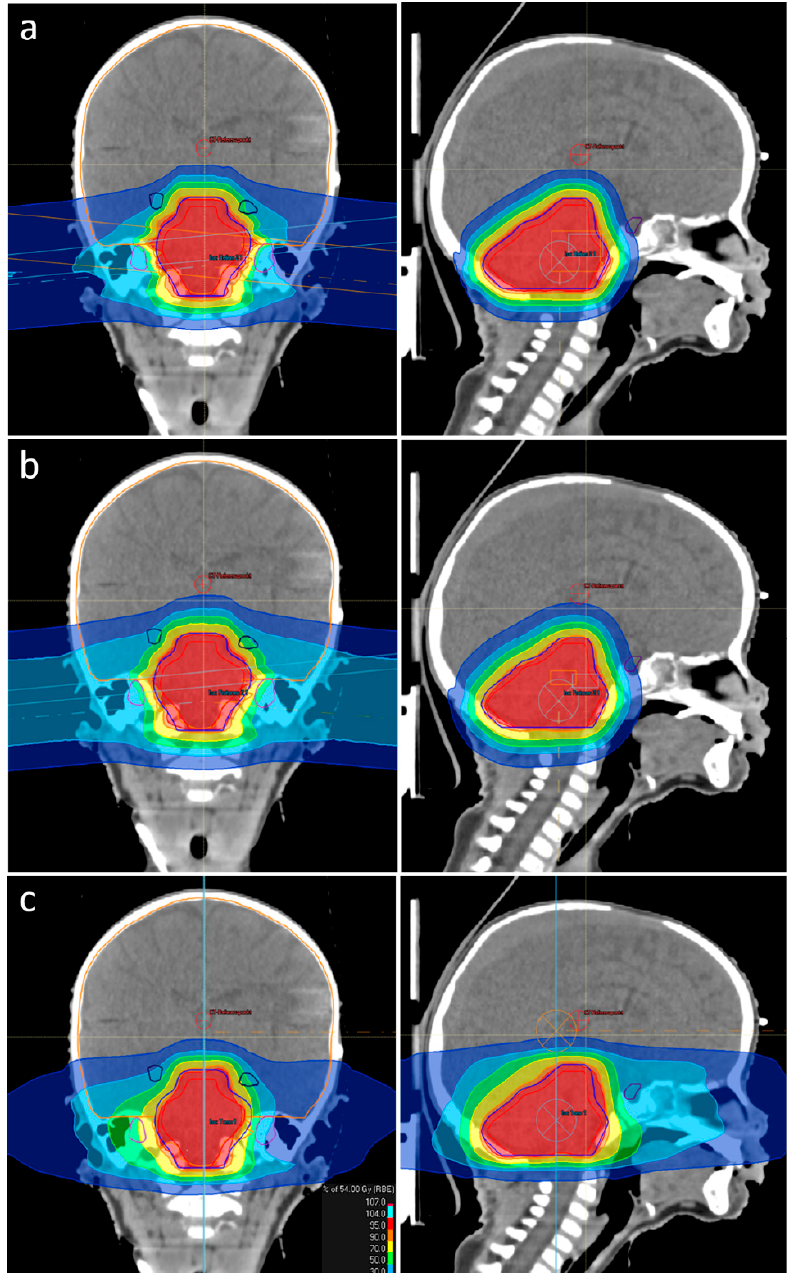
Figure 3. Comparison of dose distribution for a patient with ependymoma. ( a ) Helium ion beam therapy plan; ( b ) Proton beam therapy plan; ( c ) Helical intensity modulated radiotherapy plan. CTV is delineated in red, the pituitary gland in violet, the inner ears in purple and the hippocampi in dark blue. The treatment plan based on helium ions shows the best sparing of OAR due to steeper dose gradients.